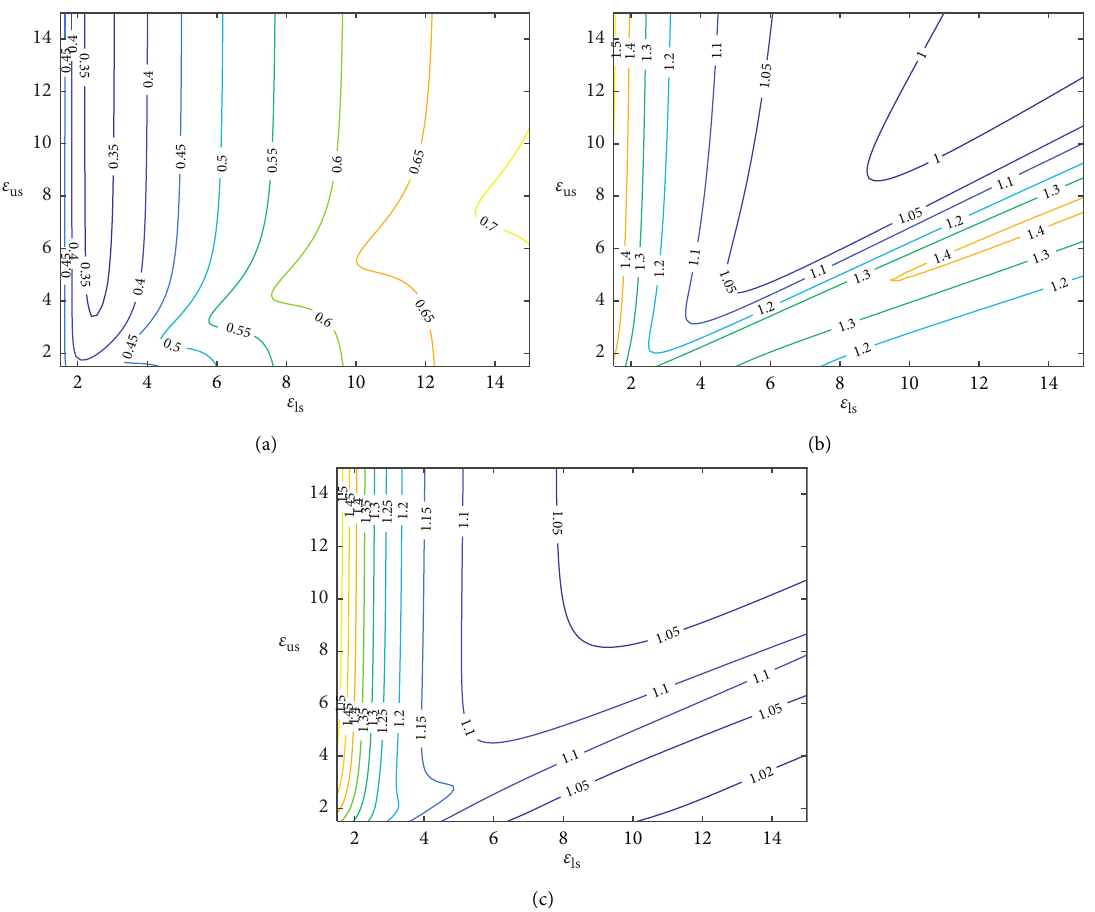
Figure 4: Variance ratios of absolute acceleration with various ε isolation mass, and (c) Ra us for the upper